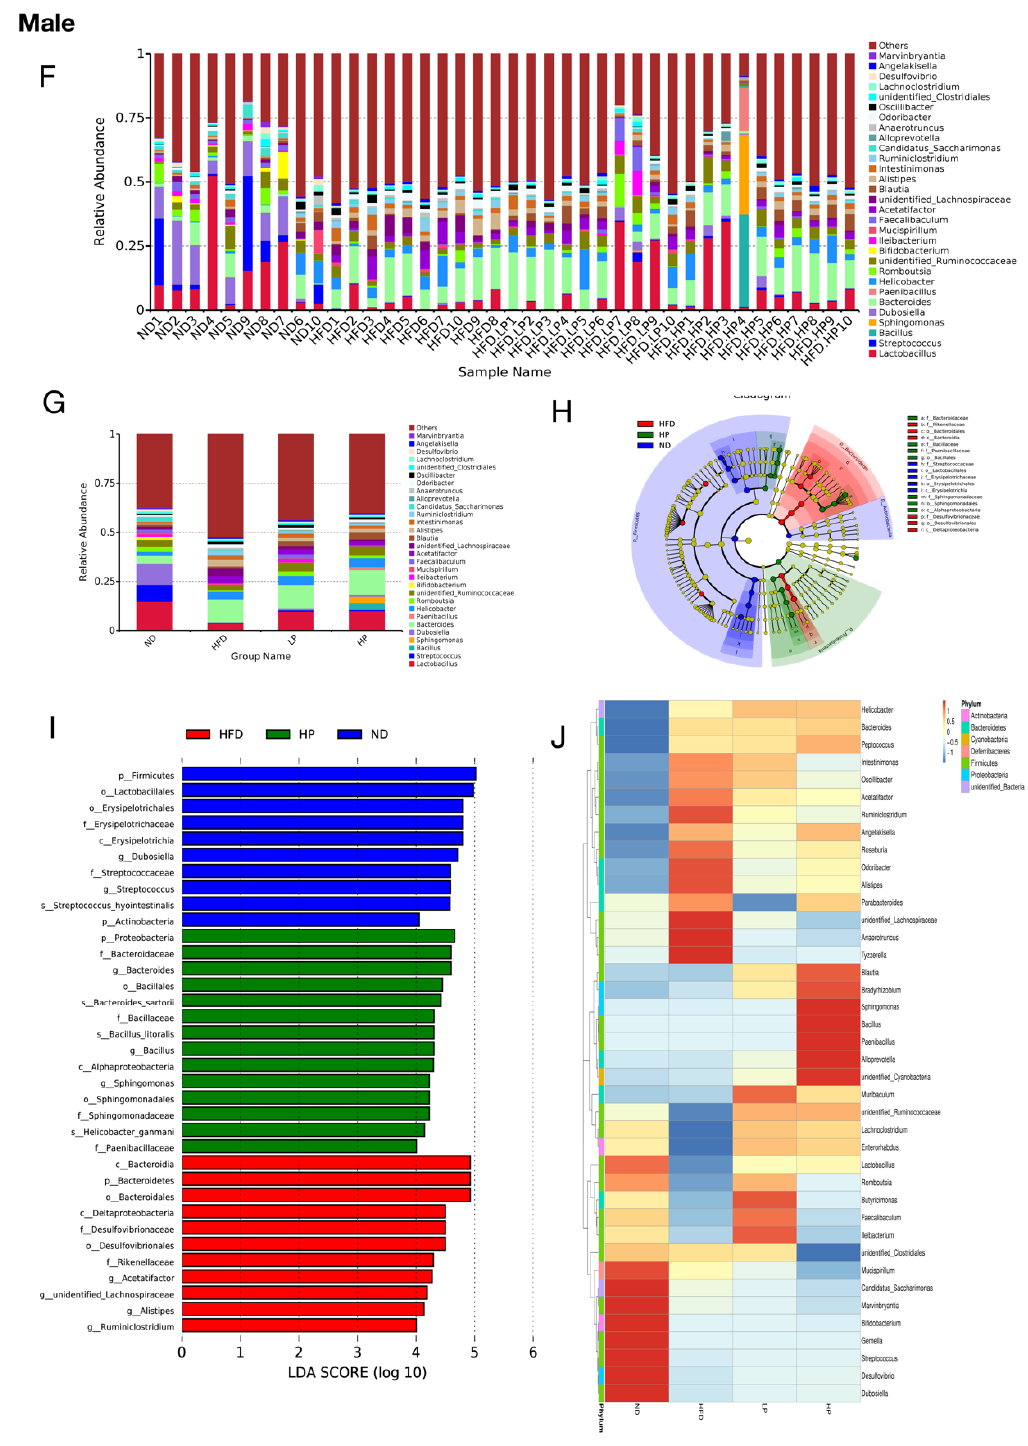
Figure 6. Di ff erences in the bacterial community induced by diet and treatment according to the relative abundances of gut microbiota at the genus level and LEfSe analysis. ( A , B , F , G ) The relative abundance of intestinal microbiota at the genus level in the four groups of both genders. ( C , D , H , I ) LEfSe results showed the change in microbiota under HFD and HP administration. The LDA significant threshold was 4.0. Red, green, and blue represented HFD, HP, ND, respectively. ( E , J ) Heat maps of taxons that were most significantly di ff erent in abundance between the four groups at the genus level generated by LEfSe analysis.